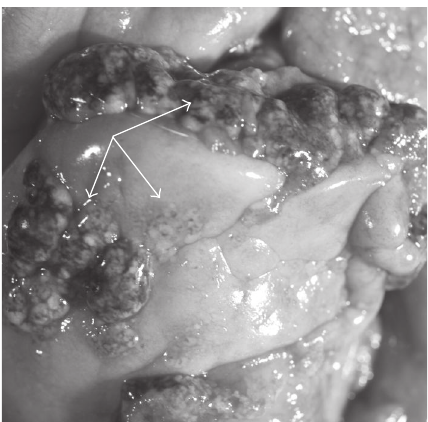
Figure 1: Gross photograph of numerous neoplastic mesothelial, exophytic, and tan to brown masses (arrows) on the epicardial and visceral pericardial surfaces of a 15-year-old cougar ( Felis concolor